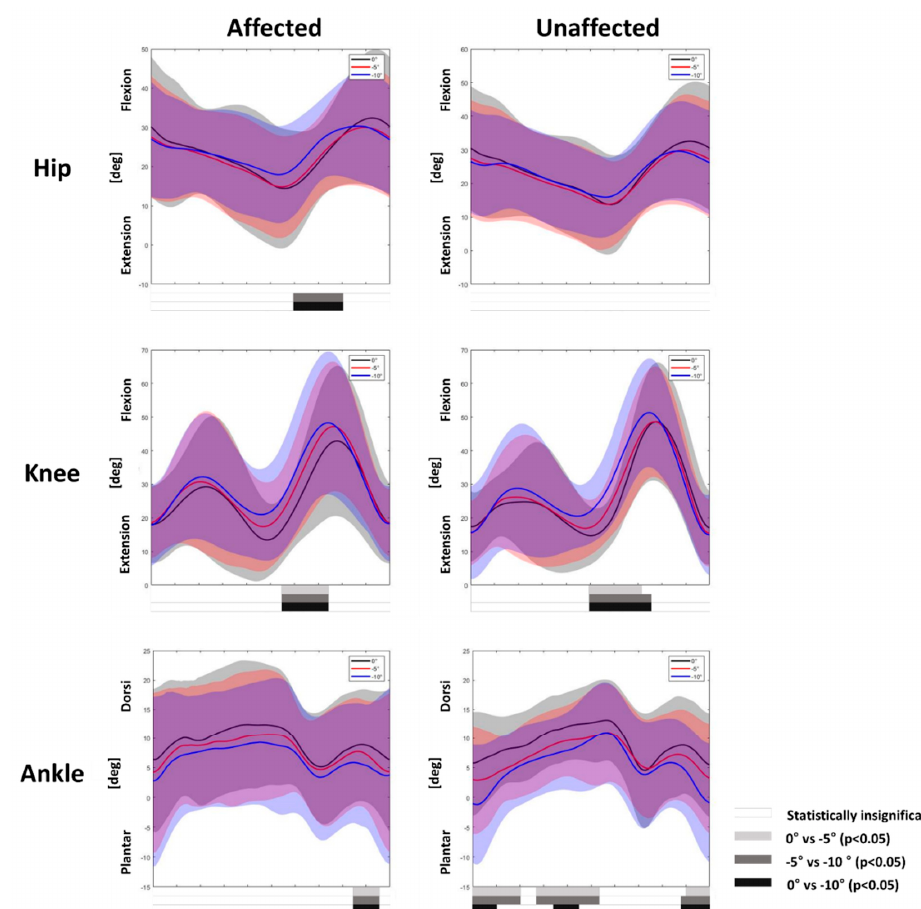
Figure 3. Joint kinematics of hip, knee, and ankle joints of the affected and unaffected legs during uphill gait. Mean kinetic angles were plotted for 0° (black), − 5° (red), and − 10° (blue), and the shaded uphill gait. Mean kinetic angles were plotted for 0 ◦ (black), − 5 ◦ (red), and − 10 ◦ (blue), and the areas indicate ±1 standard deviation. Statistically significant differences are represented by bars be- low the curves analyzed by statistical parametric mapping; 0° vs. − 5° (light gray bars), − 5° vs. − 10° shaded areas indicate ± 1 standard deviation. Statistically significant differences are represented by (gray bars), and 0° vs. − 10° (black bars). Statistically significant differences between incline gaits are bars below the curves analyzed by statistical parametric mapping; 0 ◦ vs. − 5 ◦ (light gray bars), − 5 ◦ represented by the white bars. vs. − 10 ◦ (gray bars), and 0 ◦ vs. − 10 ◦ (black bars). Statistically significant differences between incline gaits are represented by the white